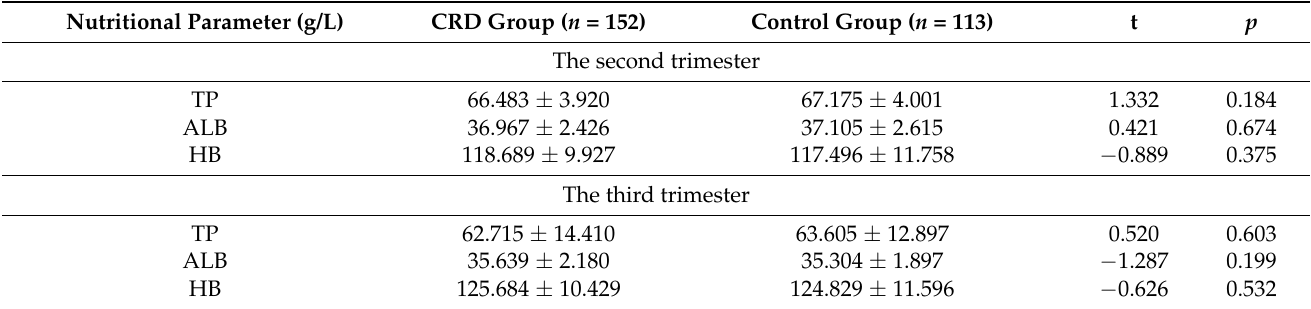
Table 6. Comparison of nutritional status between the two